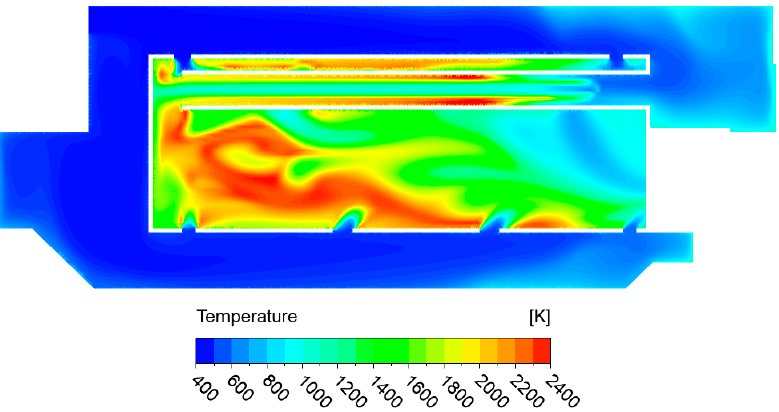
Figure 7. Streamwise temperature contour at the combustion chamber cross-section surface.